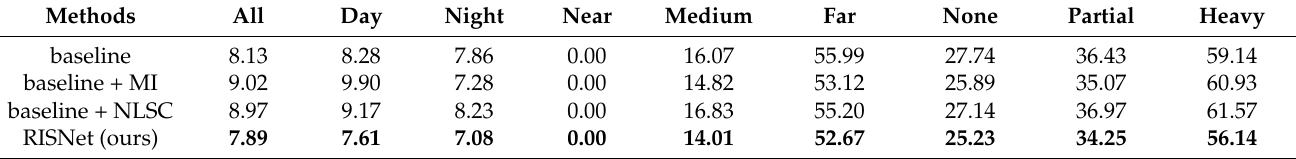
Table 5. Ablation experiments on the KAIST dataset under all nine test subsets, where the baseline is MBNet [31], MI represents the mutual information module, and NLSC represents the new lighting condition classification method. The best MR − 2 indicators are generally